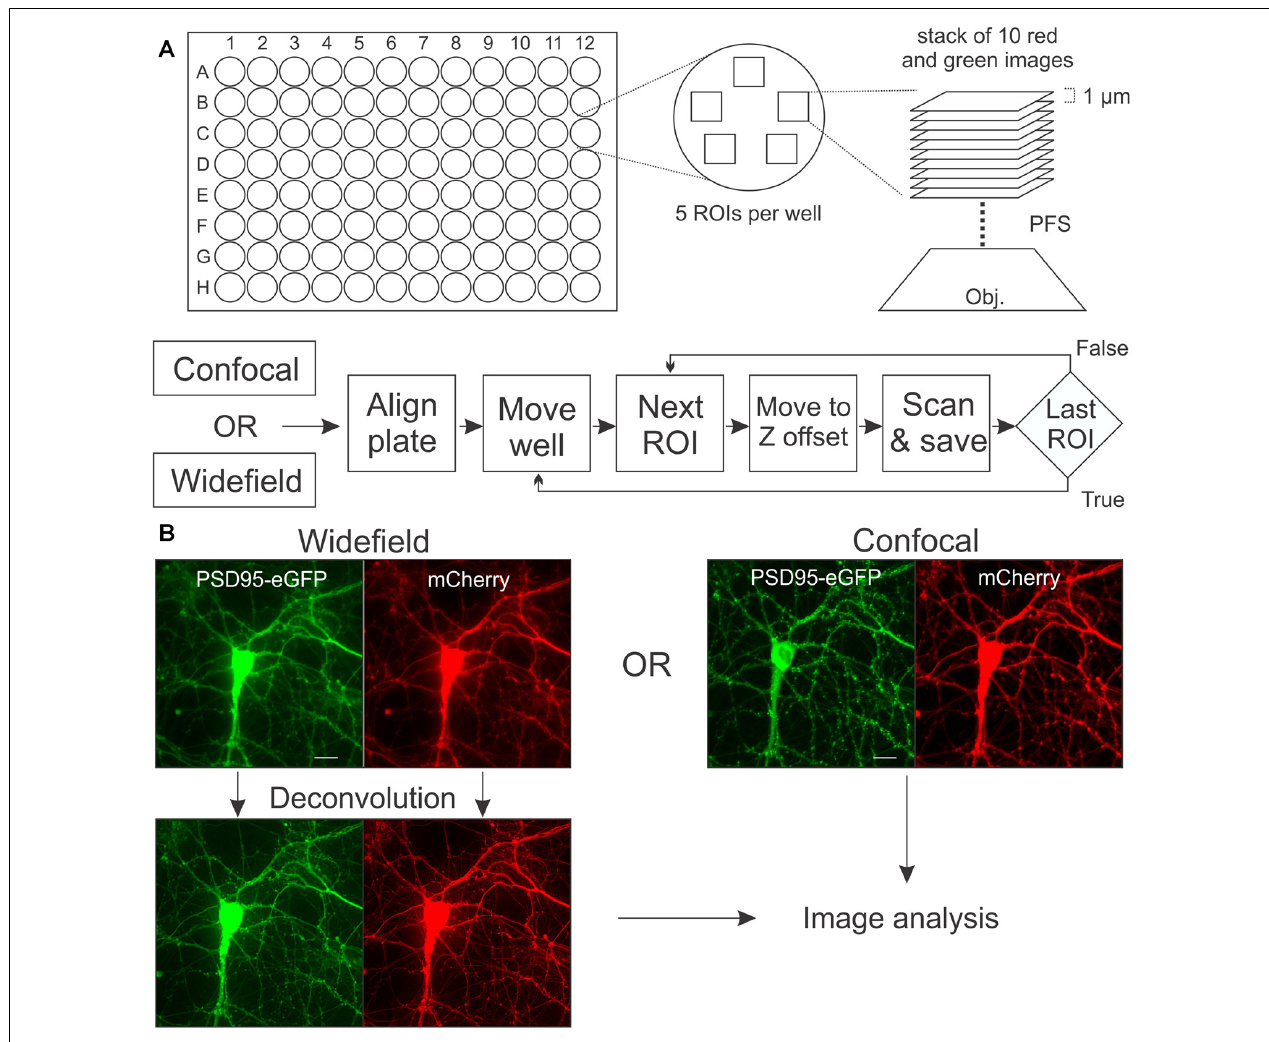
FIGURE 1 | Image acquisition. (A) In each well of a 96-well plate, a stack of 10 images separated by 1 µ M in the z-axis was collected from five regions of interests (ROIs). The perfect focus system (PFS) uses an IR laser to locate the bottom of the plate so that image acquisition begins at a precise z-offset from the bottom of the well. Flow chart shows sequence of alignment, movement and acquisition (scan) for automated microscope controlled by the JOBS module in Elements software. (B) Rat hippocampal cultures in 96-well plates were transduced using a bicistronic HdAd virus with a hSyn promoter driving independent expression of postsynaptic density 95-enhanced green fluorescent protein (PSD95-eGFP) (green) and mCherry (red). Images were collected with laser scanning confocal microscopy or with wide-field microscopy as described in “Materials and Methods” section. Maximum intensity projections (MIPs; shown) for the confocal and wide-field (after deconvolution) images are uploaded for subsequent image processing. Scale bar: 10 µ